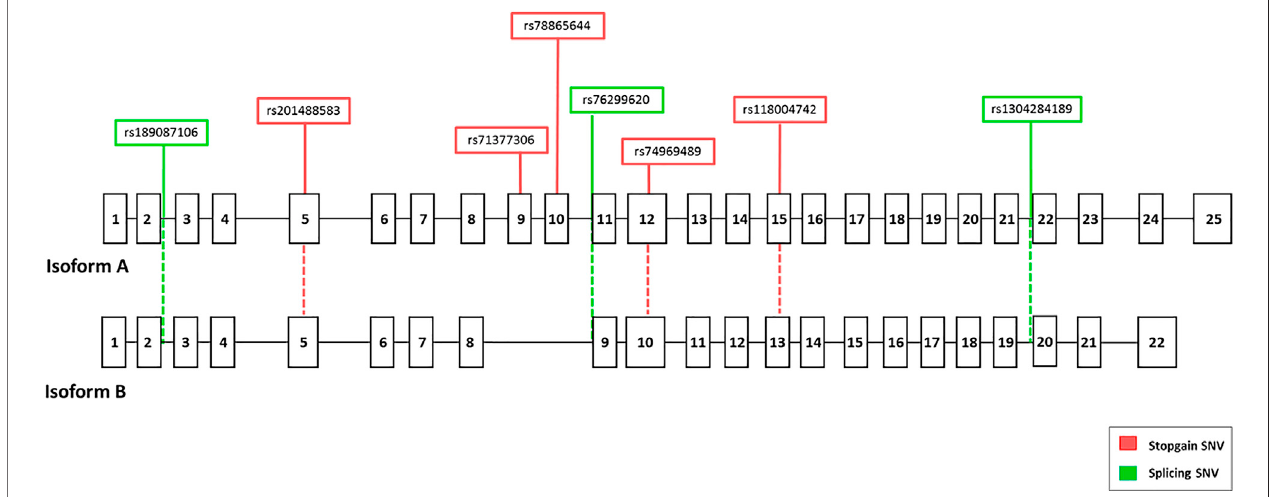
FIGURE 2 | Genomic structure of the two main isoforms of the EFCAB13 gene. GeneBank references (Ensembl) of EFCAB13 isoforms are ENST00000331493 (Isoform A) and ENST00000517484 (isoform B), respectively. The positions of the eight disruptive variants are displayed in red (stop-gain variants) or green (splicing